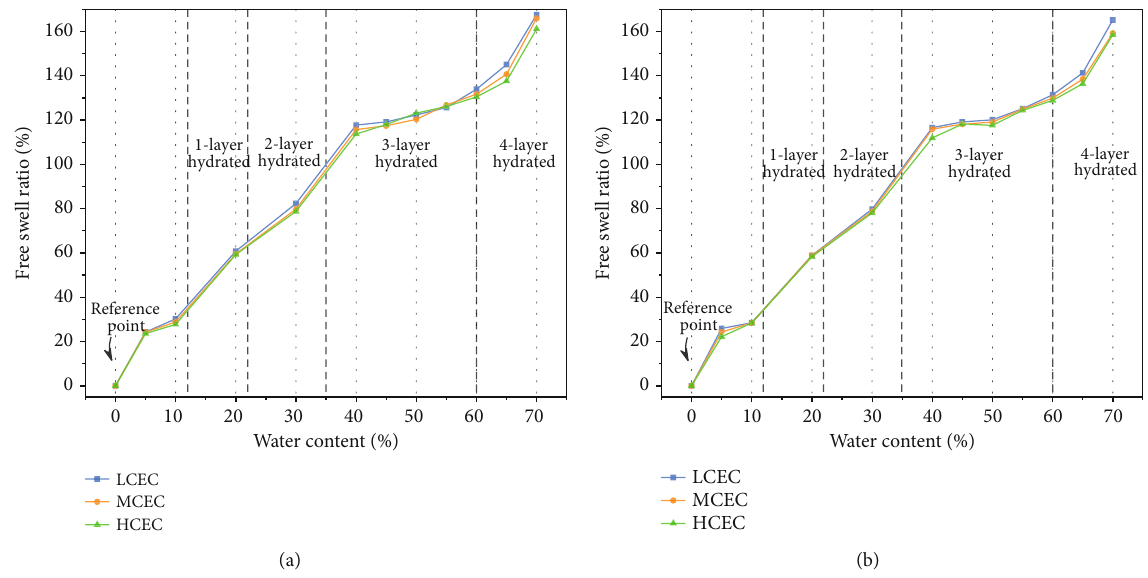
Figure 3: The relationship between free swelling ratio and water content: (a) Na-Mnt and (b) Ca-Mnt.